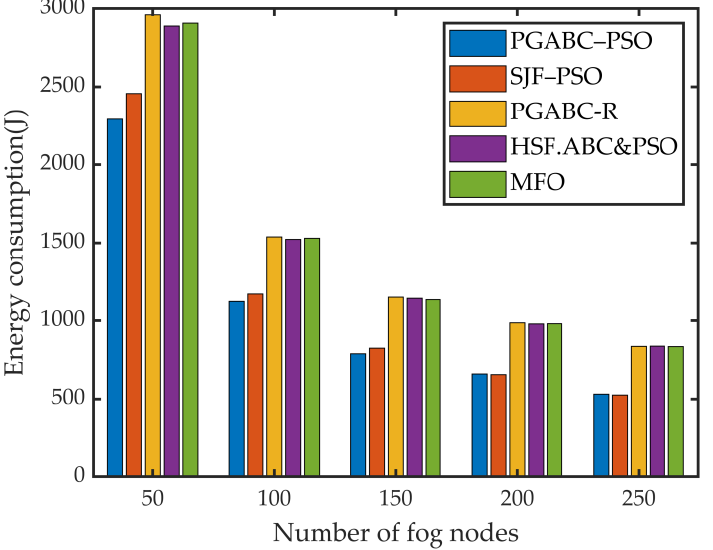
Figure 12. Total system energy consumption of five schemes varying with fog node number.